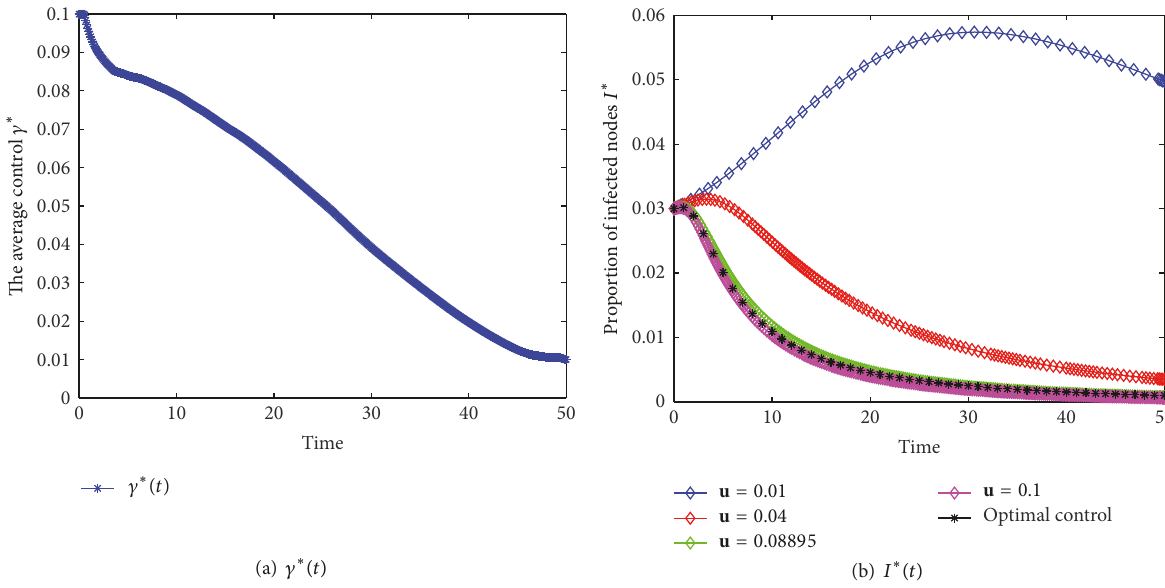
Figure 12: 𝛾 ∗ (𝑡) and 𝐼 ∗ (𝑡) under different control strategies with 𝑚 1 = 𝑚 2 = 2 for Example 3.